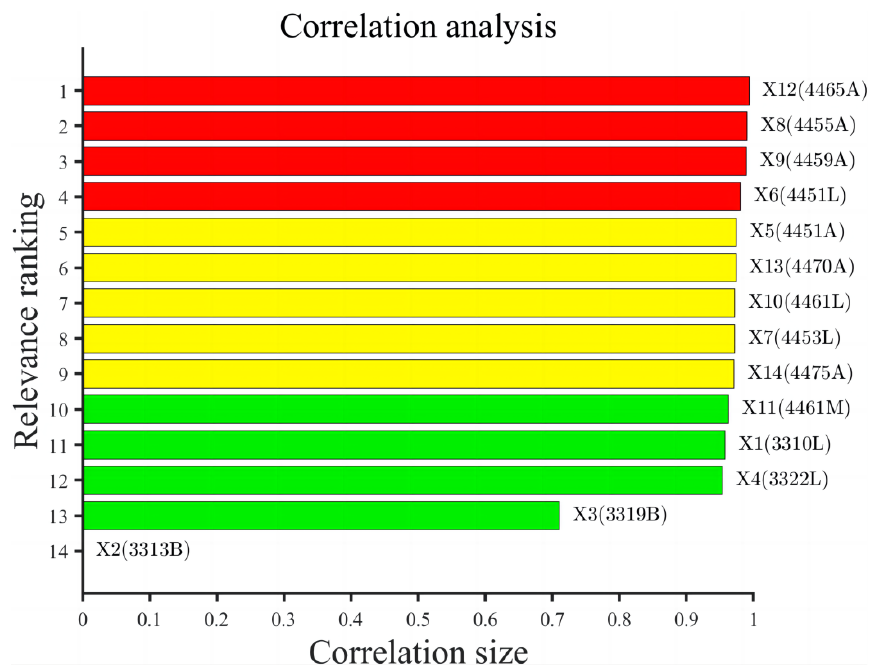
Figure 8. Correlation analysis between detection points and target points. Red indicates the four points that are highly correlated and similar to the target detection point; yellow is next; green is the last.